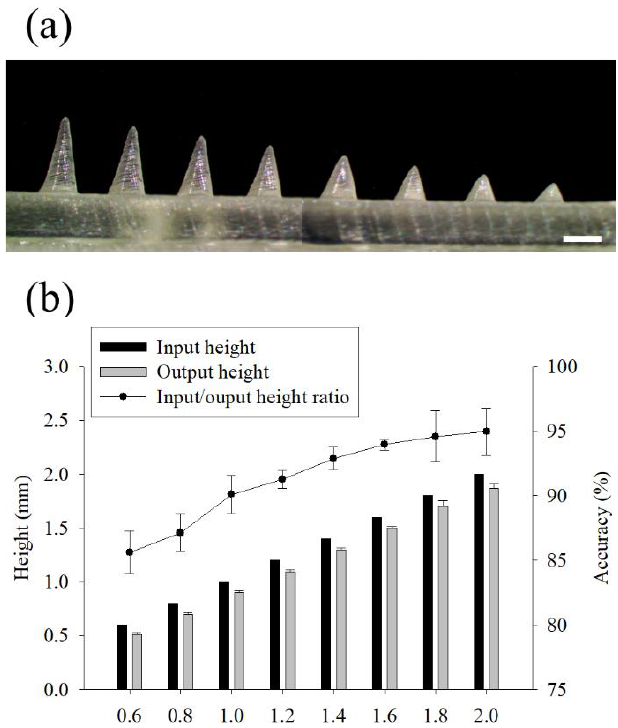
Figure 2. Effect of the input height of the microneedle on the 3D printing. Stereomicroscopic images of the microneedles with input height ranging from 600 to 2000 µm at 200 µm intervals ( a ). The ratio of the input to output and the 3D printing accuracy according to the microneedle height ( b ). ( n = 7, Scale bar is 1.0 mm).